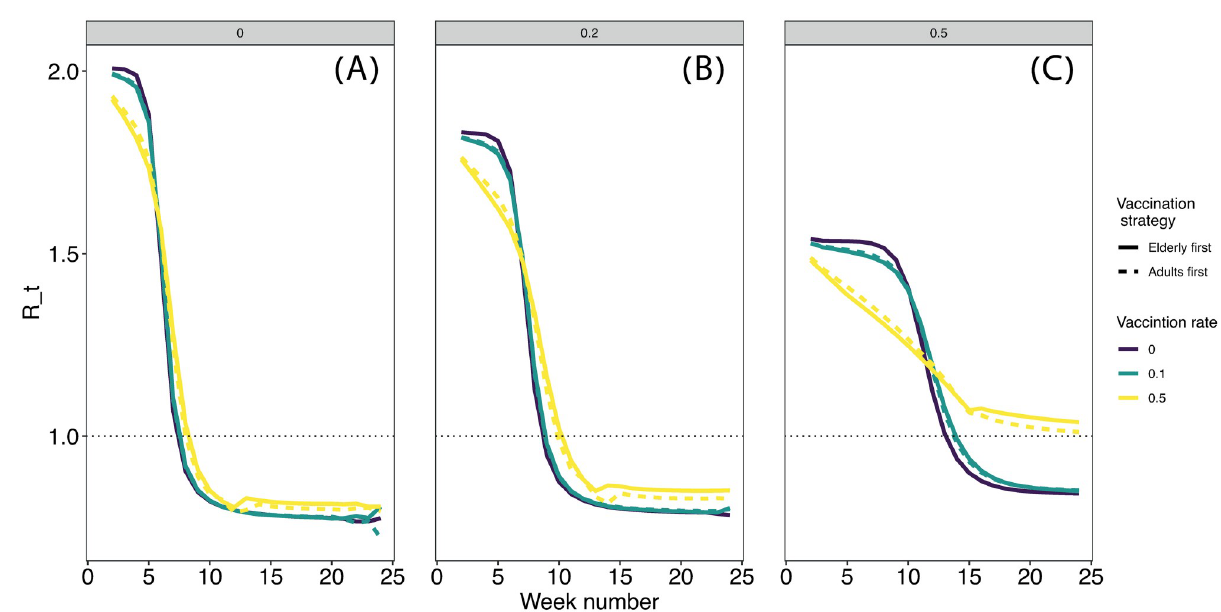
Fig 5. R t for a uniform social distancing strategy. Each panel represents a proportion of reduction in contact rates: 0 (no social distancing, panel A), 0.2 (B), and 0.5 (C). R was calculated weekly (x-axis) as descried in the main text. Other social distancing strategies are presented in S8 Fig. t